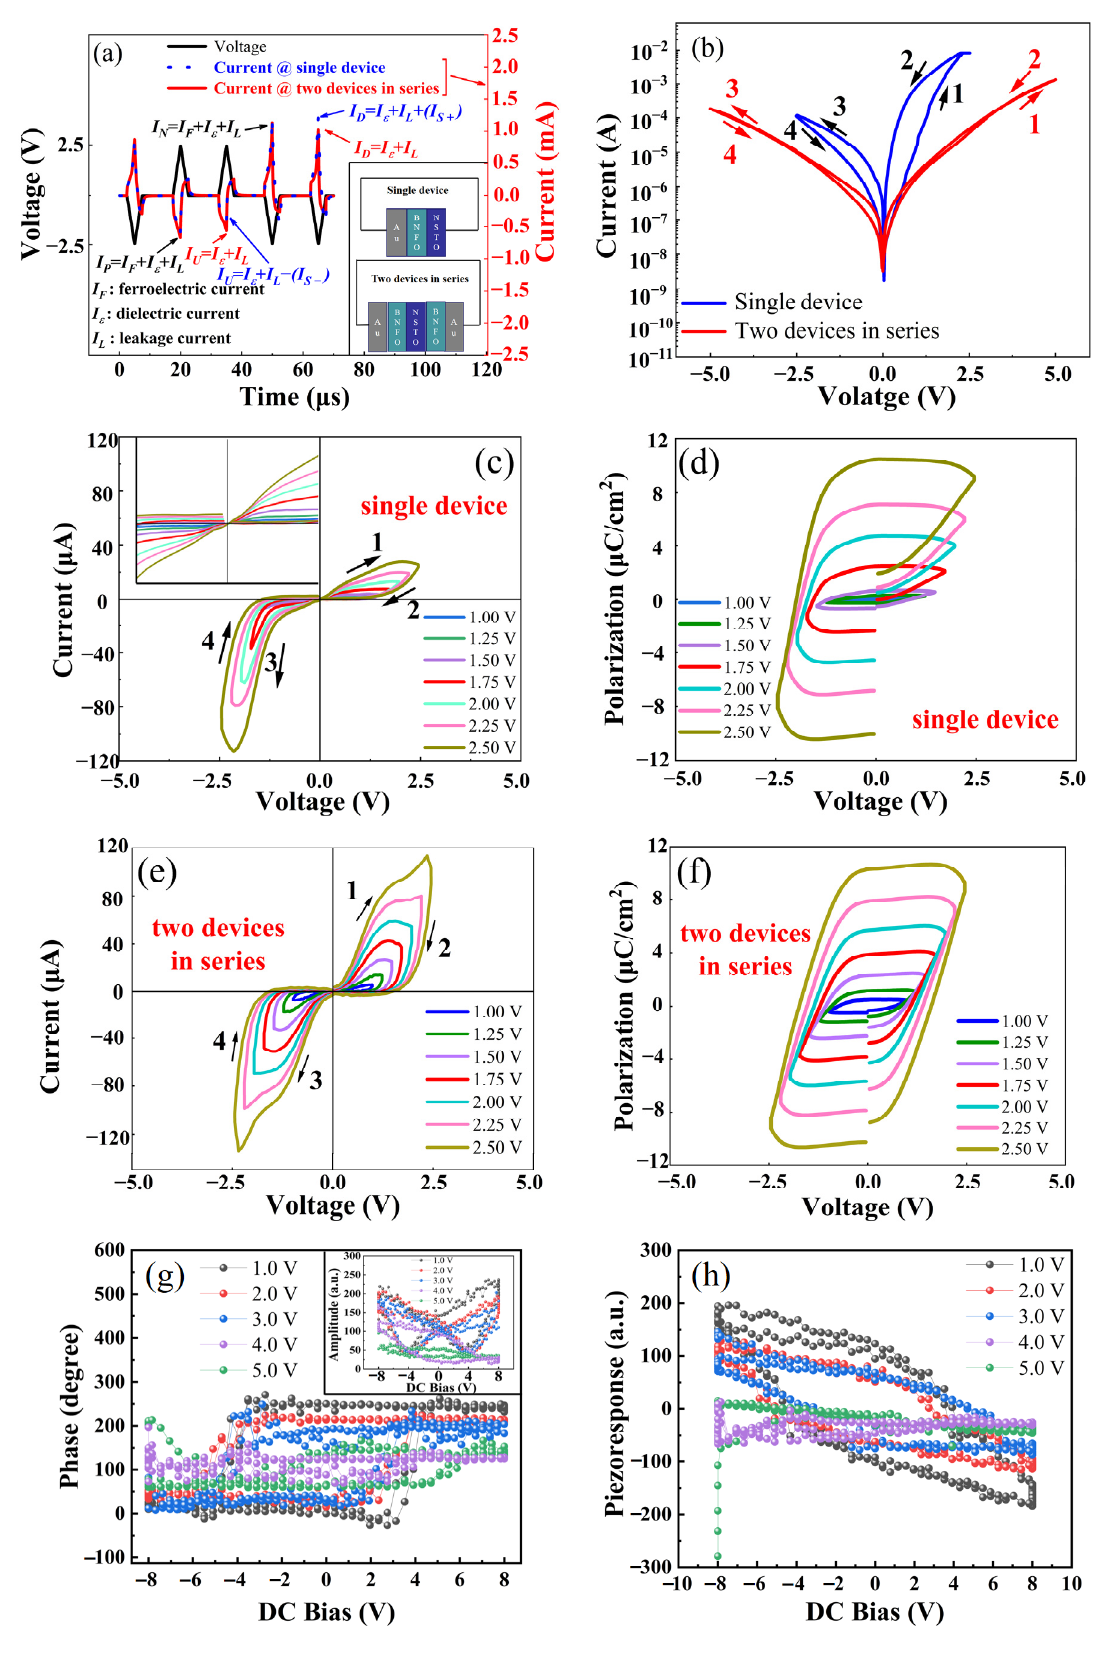
Figure 5. ( a ) PUND measurement on Bi 0 . 84 Nd 0 . 16 Fe 0 . 99 Mn 0 . 01 O 3 film of two different structures at 10 kHz. The inset shows the structure for two different measurement methods. ( b ) DC I–V curves of Au/Bi 0 . 84 Nd 0 . 16 Fe 0 . 99 Mn 0 . 01 O 3 /NSTO/In are measured on two structures, respectively. ( c ) The I–V loop